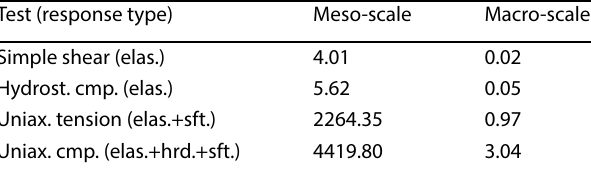
Table 2 CPU time (s) for meso-scale versus macro-scale computa- tions performed for different identification tests Test (response